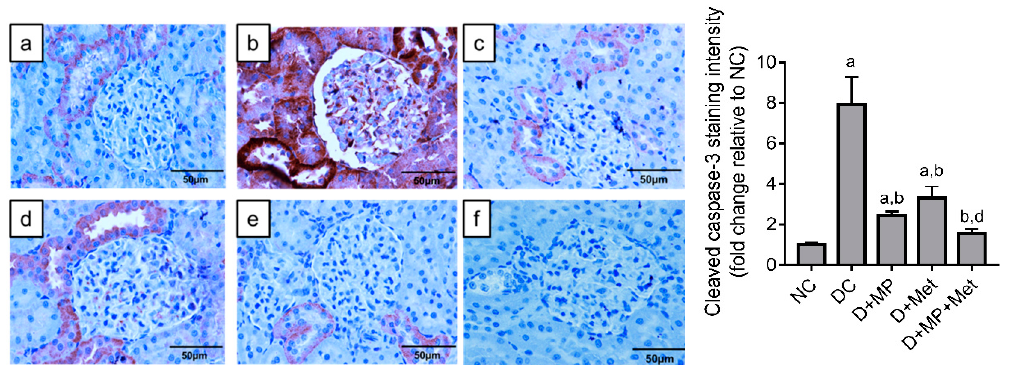
Figure 7. Cleaved caspase-3 immunoexpression in the kidney of diabetic rats. ( a ) NC, ( b ) DC, ( c ) D + MP, ( d ) D + Met and ( e ) D + MP + Met groups. Negative control is presented as ( f ). Photographs were taken at 400 × magnification (scale bar = 50 µm). Immunoexpression of cleaved caspase-3 was presented as fold change relative to NC group. Values are mean ± SD, n = 6; a p < 0.05 versus NC; b p < 0.05 versus DC, d p < 0.05 versus D + Met (one-way ANOVA, followed by Tukey post hoc test).